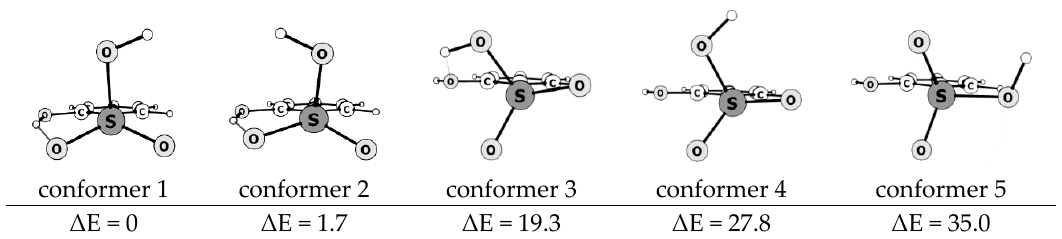
Figure 9. The structure of the 2-HO-BSA conformers and their relative energies ( Δ E, kJ mol − 1 ).